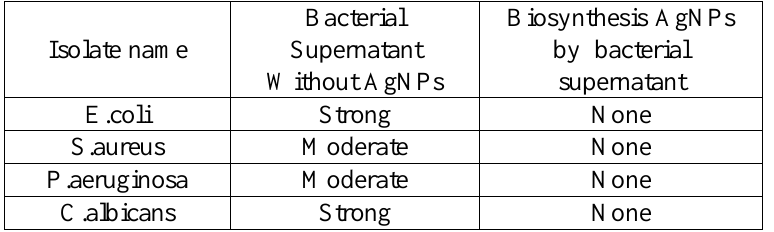
Table (1) Biofilm activity using test tube method for different